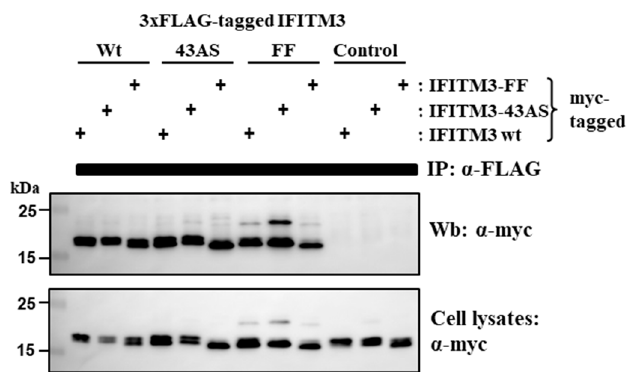
Figure 4. Mutation of F75 and F78 in IFITM3 does not alter homotypic interactions. 293T cells were transfected with plasmids encoding IFITM3-wt, IFITM3-FF or IFITM3-43AS tagged at the N-terminus